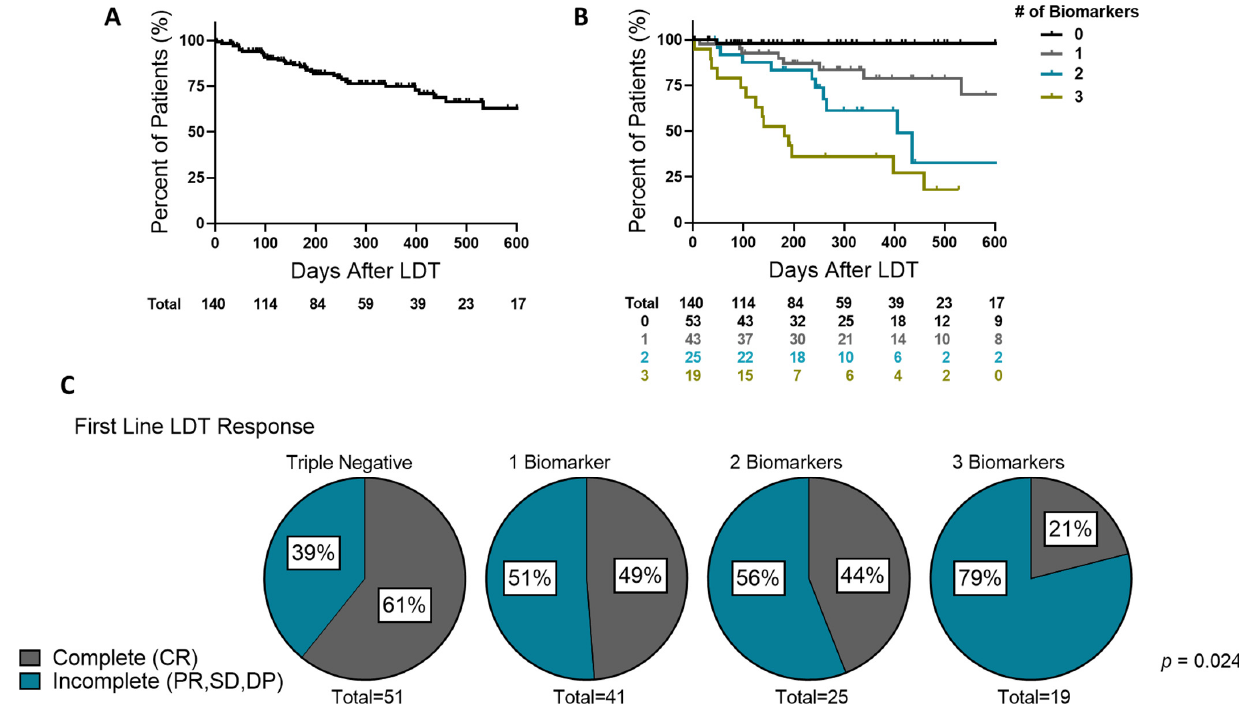
Figure 3. Time to Progression and First Line LDT Response by Biomarker Count. ( A ) Kaplan Meier curve of time to progression for the entire study cohort with total surviving patients at each time listed in the table below the graph. ( B ) Kaplan Meier curve of time to progression stratified by total biomarker count. ( C ) Percentage of patients with a complete re-sponse to first line LDT broken down by initial biomarker count. P value indicates significance in Chi Square Likelihood Ratio Test. Censored data in the Kaplan Meier curves is marked with a vertical upward dash .